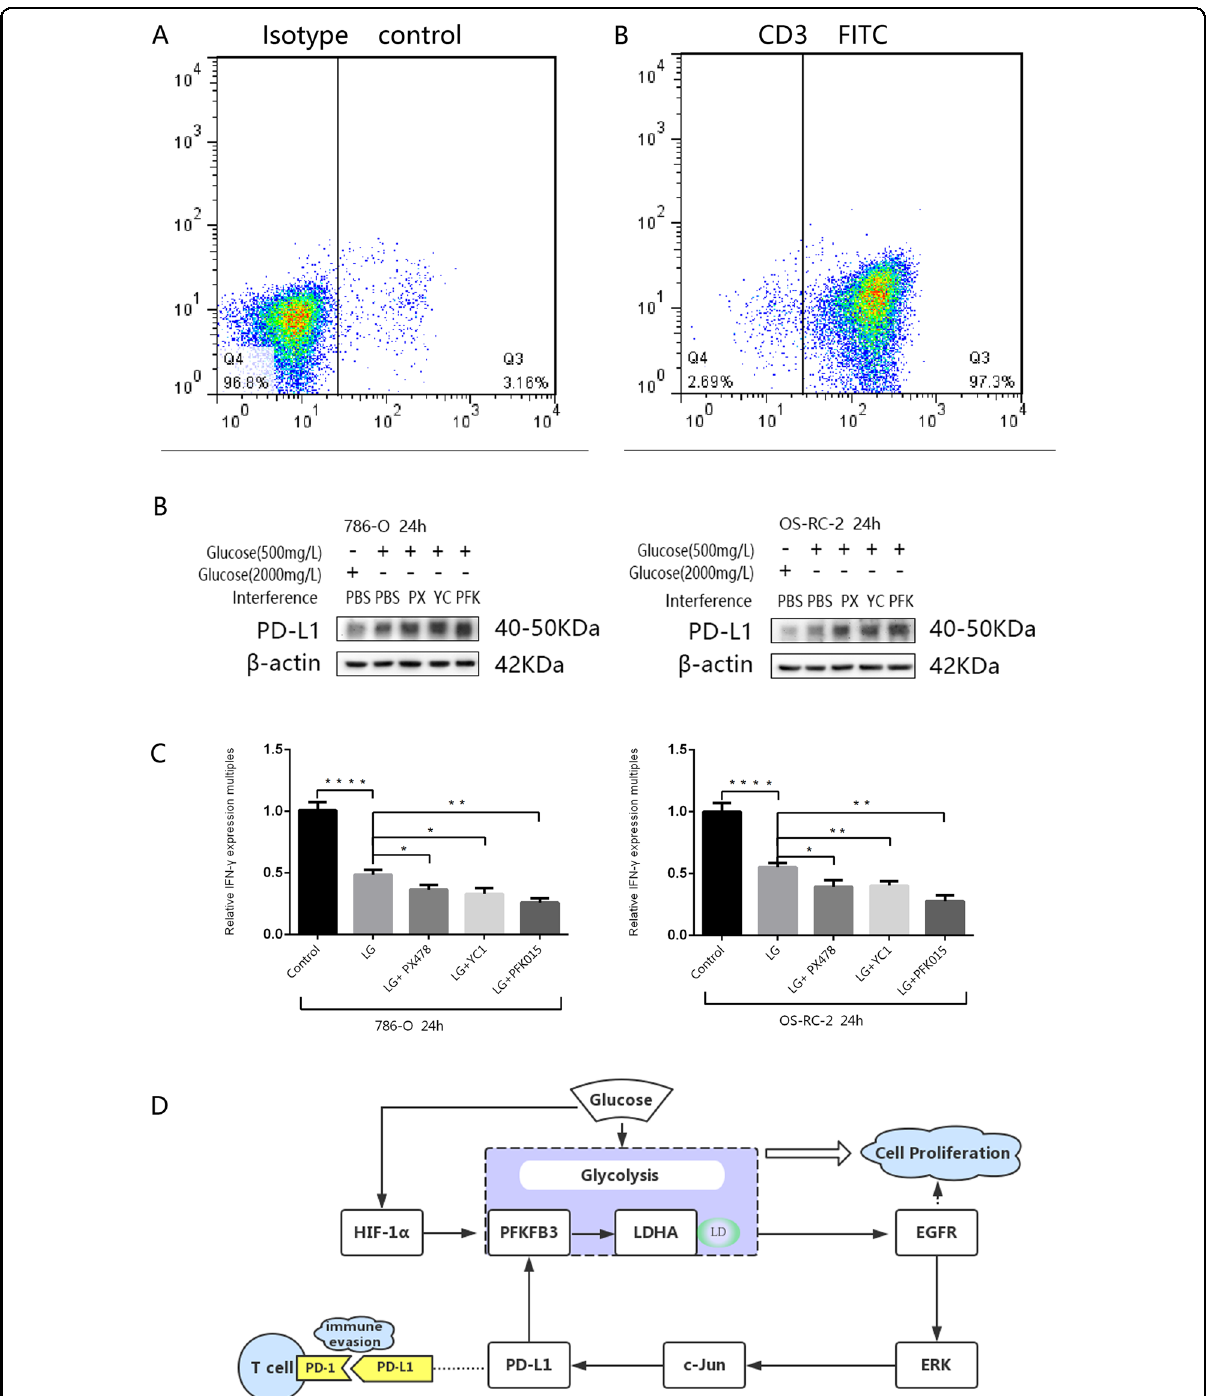
Fig. 7 Difference in IFN and PD-L1 expression levels during CD3 and renal cancer cell co-culture under different intervention conditions and integration of the whole mechanism pathway. A The purity of T cells was con fi rmed by fl ow cytometry using an anti-CD3 FITC-conjugated antibody compared with a mouse isotype control antibody. B Protein levels of PD-L1 in 786-O and OS-RC-2 cells cultured in normal culture medium, glucose-free culture medium and glucose-free culture medium with PX-478 (40 mmol/L), YC-1 (10 mmol/L) and PFK-015 (10 mmol/L) for 24 h are shown. C After the two tumour cell lines were cultured alone under various conditions for 24 h and then cocultured with CD3 + lymphocytes for another 24 h under normal RPMI 1640 medium conditions, the expression level of IFN- γ in the supernatant of the culture system was detected by ELISA. D The pathway diagram summarises the relationship between glycolysis and its associated proteins and PD-L1. Independent experiments were performed in triplicate. Data are expressed as mean ± SD. * P < 0.05, ** P < 0.01, *** P < 0.001 and **** P < 0.0001.